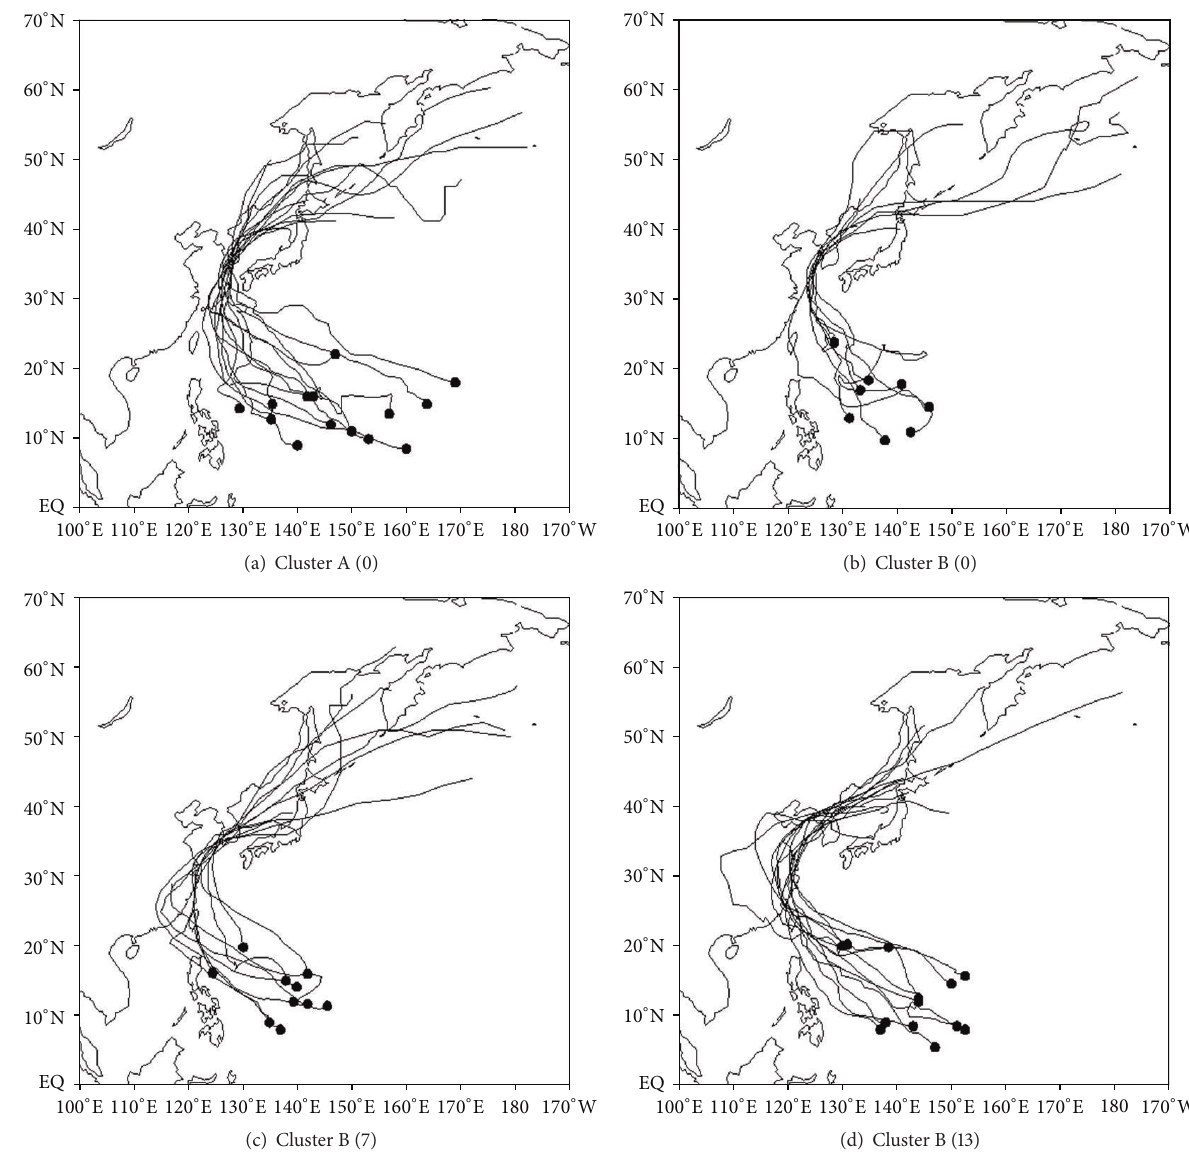
Figure 13: Same as Figure 12 but for the full-track. Small solid dots denote each TC genesis location of Korea-landfall TCs, respectively. The numbers in the parentheses represent TC frequencies without passing through mainland China.